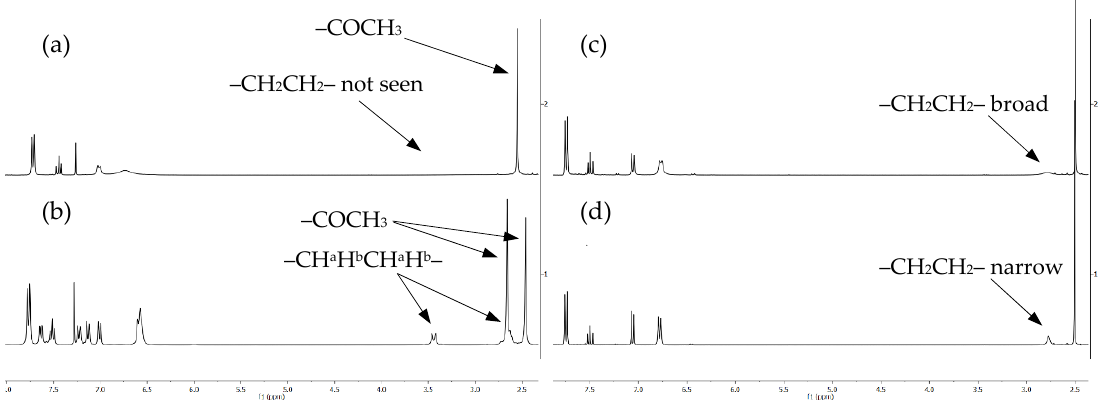
Figure 1. Variable temperature 1 H NMR spectra (300 MHz) of 9a : a ) in CDCl 3 at 302 K, b ) in CDCl 3 at 230 K, c ) in CD 3 CN at 302 K, d ) in CD 3 CN at 320 K.